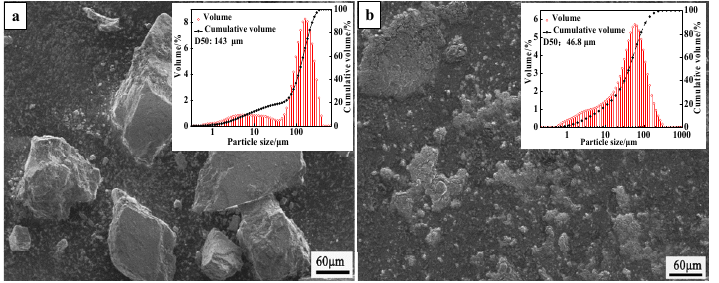
Figure 2. The SEM and particle size with LCM of different kinds. ( a ) coarse LCM ( b ) fine LCM.